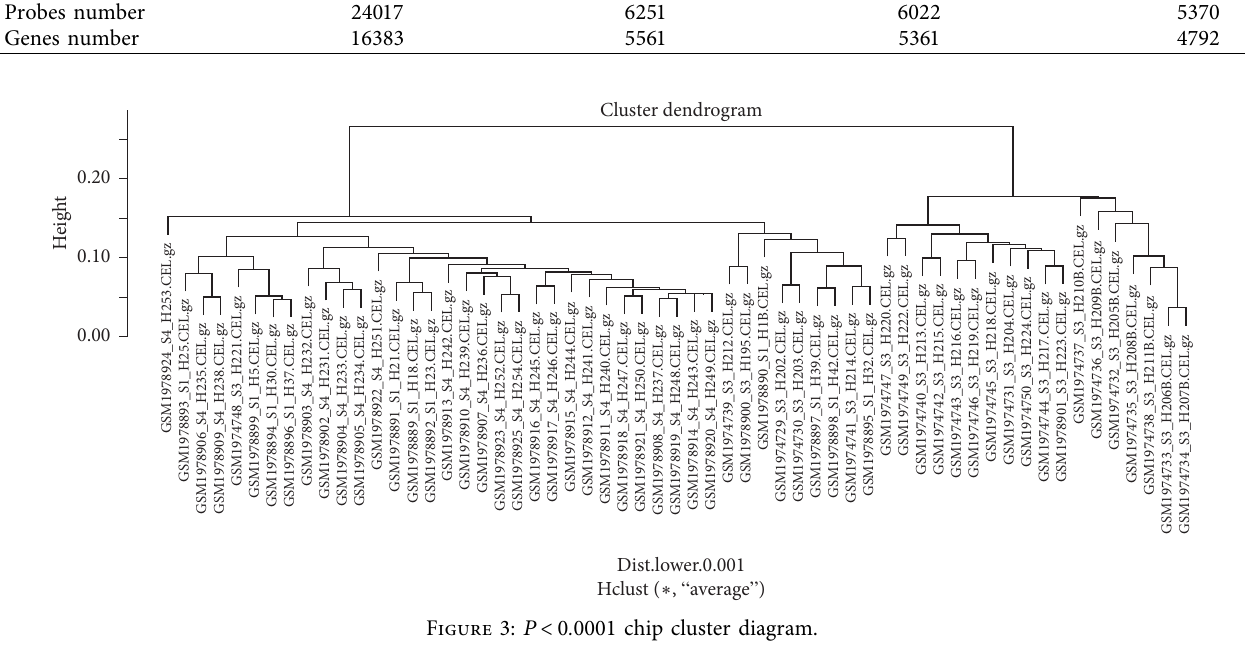
Figure 3: P < 0 . 0001 chip cluster diagram.